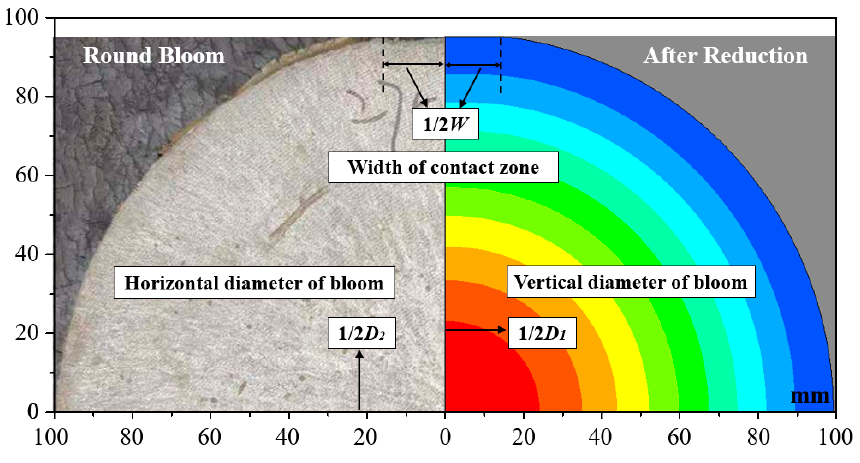
Figure 4. Round bloom shape in the simulation and experiment.